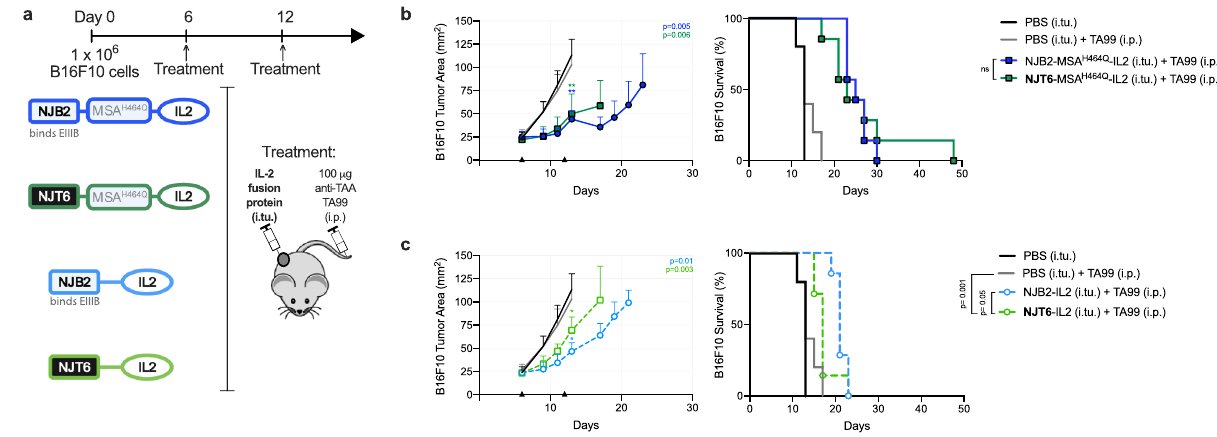
Fig. 4 Contribution of size to exposure outweighs target-binding af fi nity for less abundant target EIIIB. a Schematic of the B16F10 tumor immunotherapy study timeline (top) and treatment components (bottom). Mice were inoculated with 1 × 10 6 B16F10 cells subcutaneously in the right fl ank on day 0. Six days after tumor implantation, treatments were initiated following the timeline. ( n = 5 mice for the PBS (i.tu.) and PBS (i.tu.) + TA99 (i.p.) groups, and n = 7 mice for all other groups). TAA tumor-associated antigen, i.tu. intratumoral, i.p. intraperitoneal. b , c Tumor growth over time (left, mean + s.d.) and survival (right) of the indicated groups. Tumor area for each group is shown until a mouse in the group is euthanized due to tumor burden. Statistical signi fi cance of each treated group ’ s tumor area (displayed on top right corner) was calculated by using a one-tailed Student ’ s t -test versus the PBS (i.tu.) + TA99 (i.p.) group on day 11. Comparisons for each treated group ’ s survival was calculated by using a log-rank Mantel-Cox test. * P < 0.03; ** P < 0.002; *** P < 0.0002; **** P < 0.0001; n.s. not signi fi cant. Source data for panel b , c are provided in the Source Data fi le. Panel a was created with